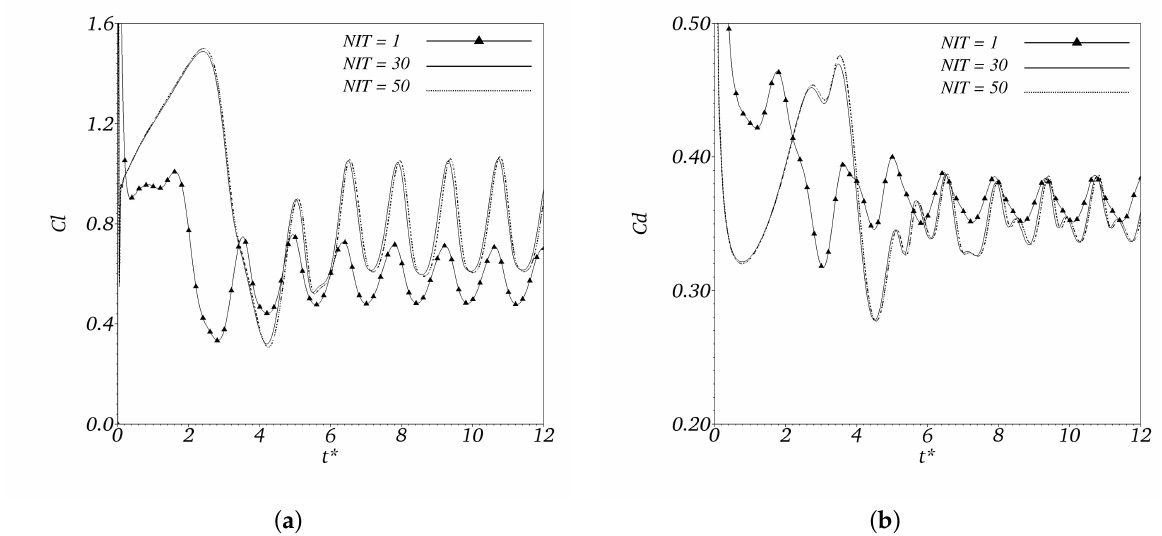
Figure 9. Temporal evolution of ( a ) C l and ( b ) C d for different NIT